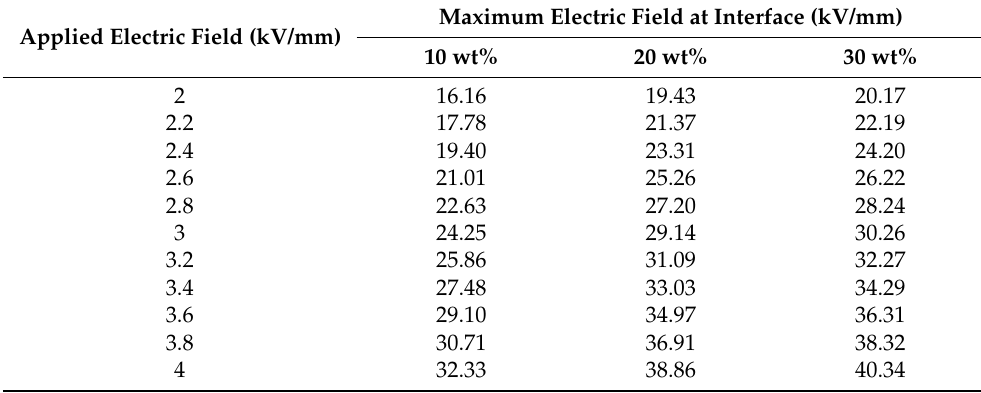
Table 6. Maximum interface electric field intensity under different external electric fields.